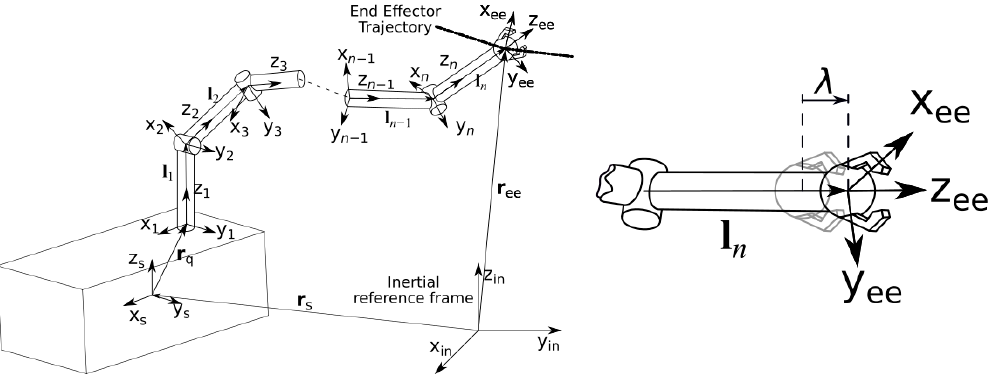
Figure 1. Schematic depiction of reference frames of a robotic arm on a satellite base ( left ). Detail showing the end effector with the prismatic joint displacement ( right ).